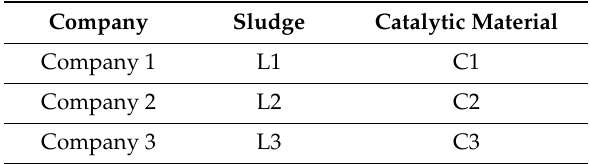
Table 3. Nomenclature used for the di ff erent sludges